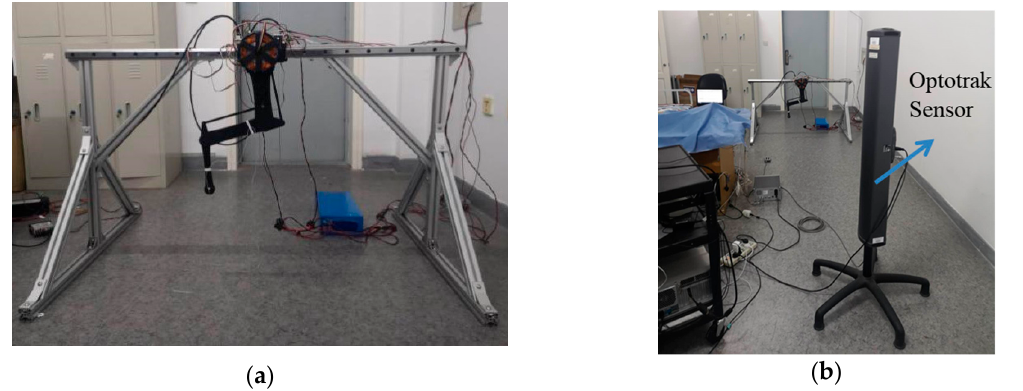
Figure 18. Experimental platform. ( a ) One leg experimental platform. ( b ) Trajectory measurement with Optotrak sensor.